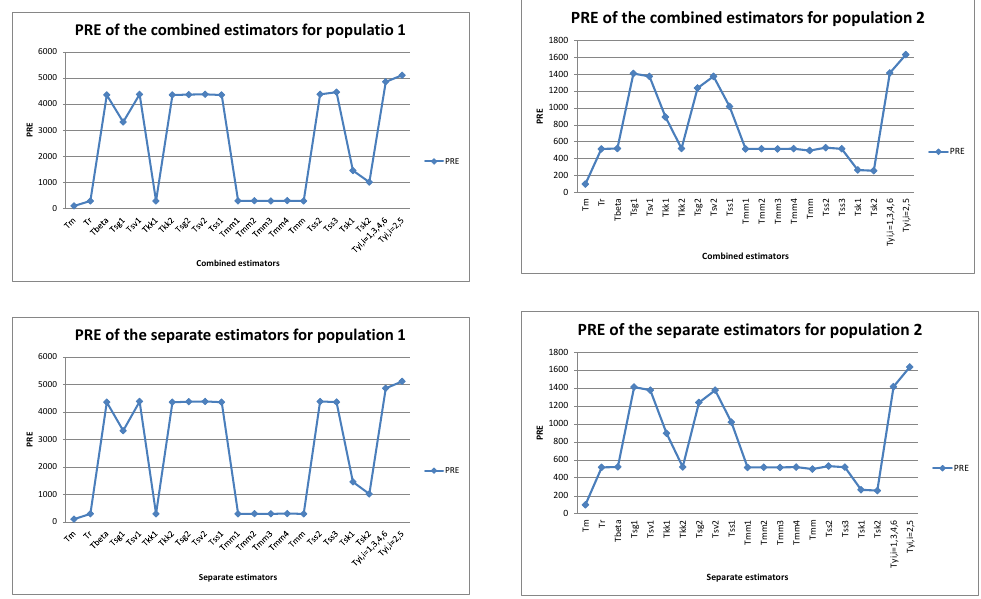
Figure 1. PRE of the combined and separate estimators for real